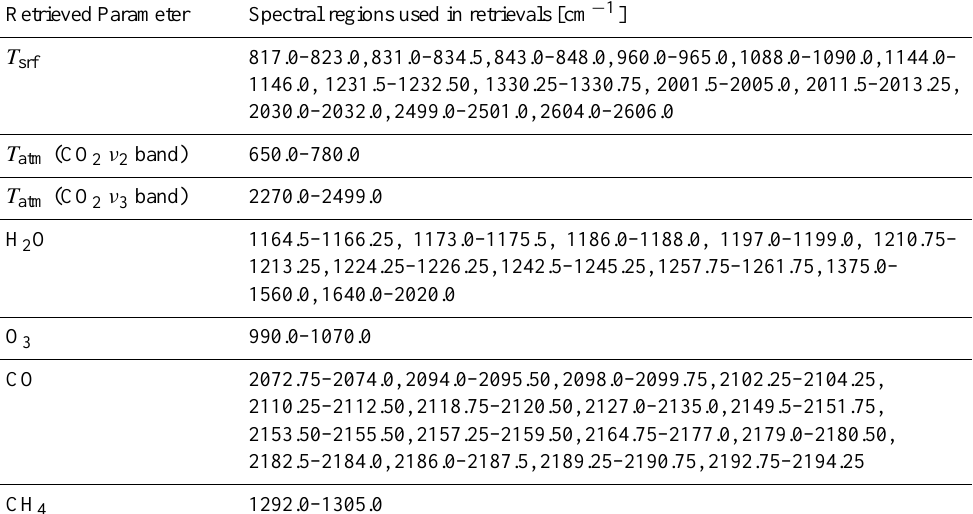
Table 2. List of spectral regions used in the retrievals. Retrieved